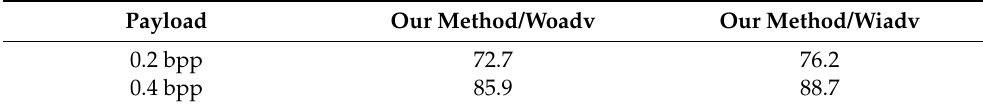
Table 2. Detection accuracy (%) for steganography at 0.2 bpp and 0.4 bpp on BOSSBase1.01 using S-UNIWARD for networks without and with the introduction of the adversarial